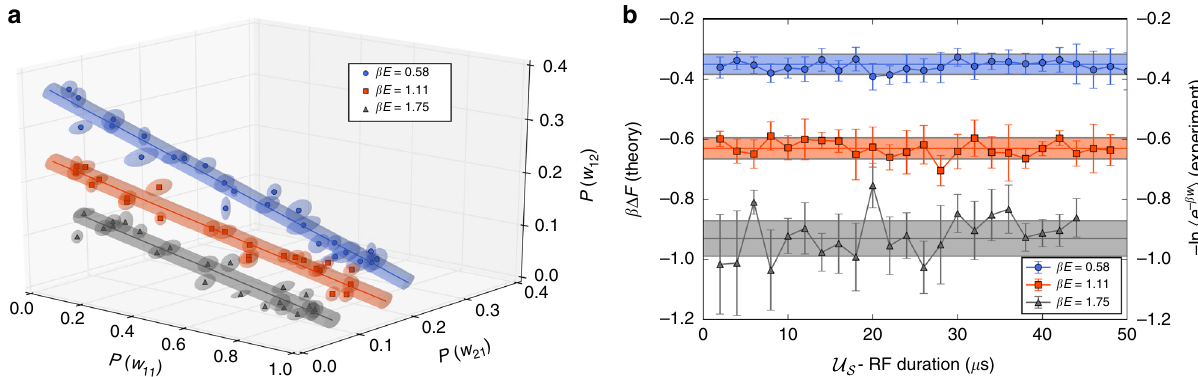
Fig. 2 The Jarzynski identity. a Each point de fi nes a probability vector (with its experimental error) measured for a certain driving. The three lines correspond to three temperatures: β E ¼ 0 : 58 ± 0 : 02 (blue circle), 1.11 ± 0.02 (red square) and 1.75 ± 0.04 (grey triangle). For each temperature all points lie in the same Jarzynski manifold (which in this case is a line). Reported errors are the SEM of three independent experiments with the same initial parameters and driving. The projections onto the three different axes of the probabilities are shown in detail in Supplementary Fig. 2. (cid:4) (cid:5) P e (cid:2) β w P ð w Þ becomes independent of the duration of the intermediate driving (for three temperatures). The dots are the calculated b (cid:2) ln h e (cid:2) β w i ¼ (cid:2) ln w values using the measured work distribution in the Jarzynski identity, and the solid line is the theoretical estimate of β Δ F (with an uncertainty due to the uncertainties in the temperature and energy splitting). Error bars are the SEM